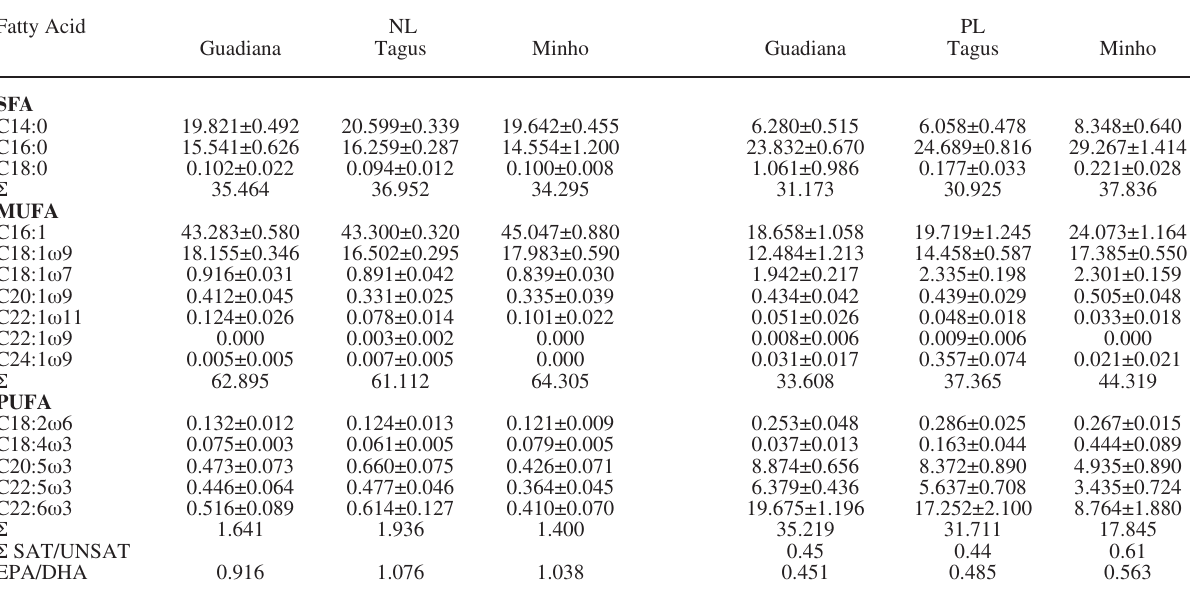
Table 2. – Fatty acid composition of the neutral lipid (nl) and polar lipid (Pl) fractions of sea lamprey muscle from the Guadiana, tagus and minho river basins. values are expressed as percent of total fatty acids, mean ± Sd, n=15 Fatty